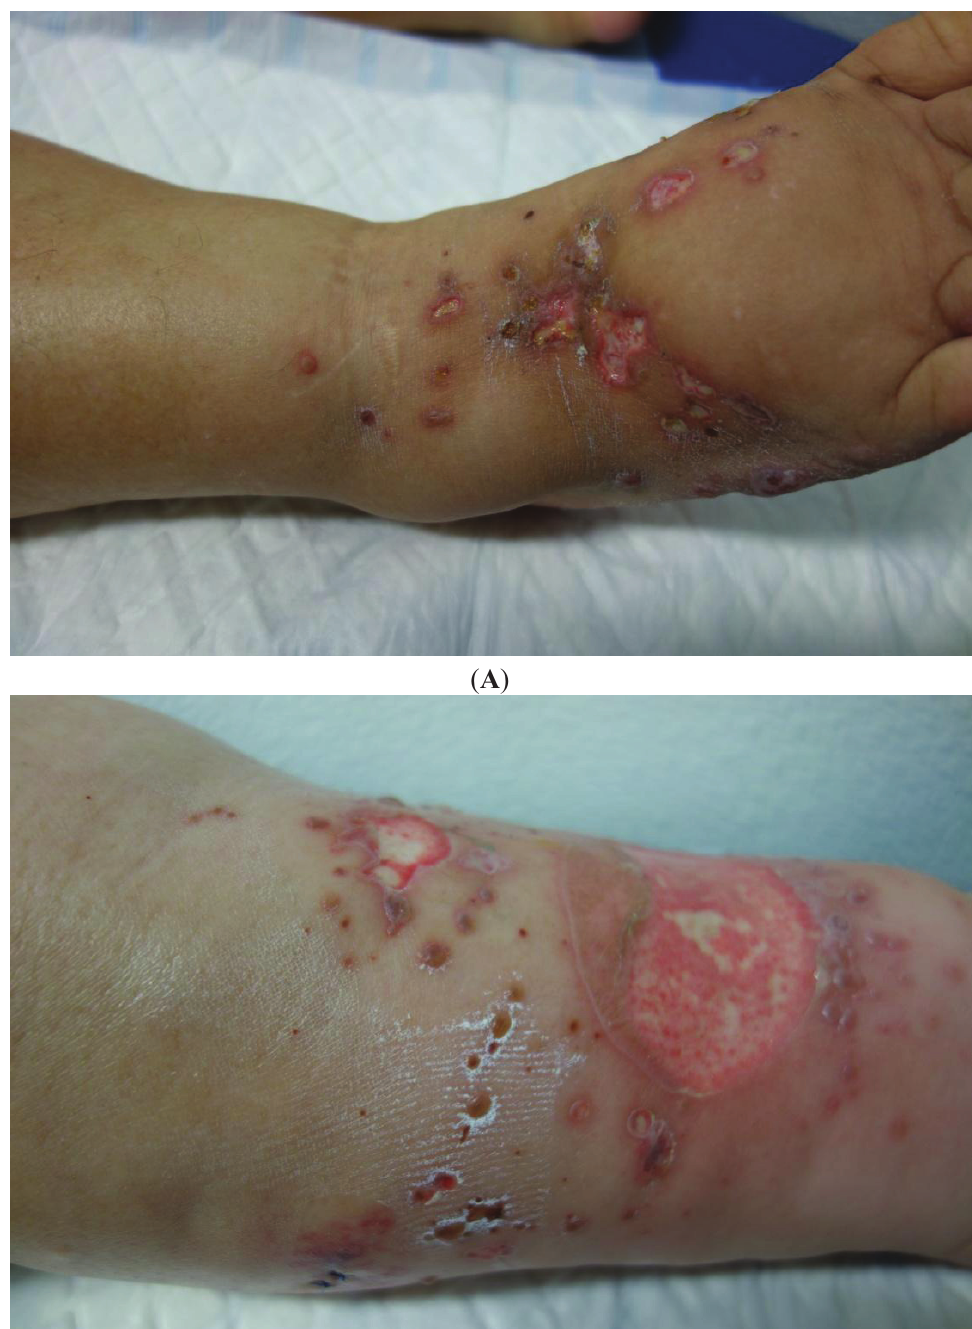
Figure 1. Erosions and ulcers affecting the dorsal aspect of the right foot ( A ) and the anterior, inner and outer surfaces of the left leg ( B